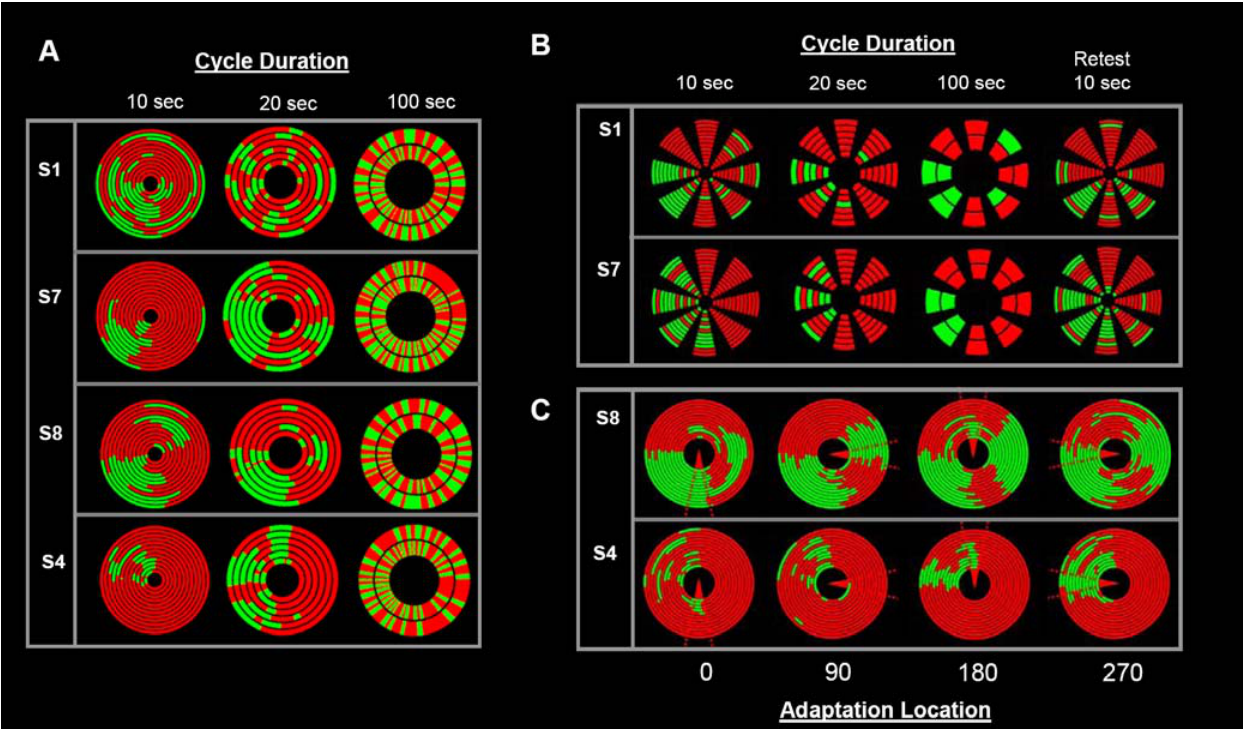
Figure 3. Results from experiment 3, 4 and 5. (A) Data from all 4 subjects tested with 3 different speeds of smooth motion of the target around a peripheral trajectory (the same radial distance used in experiment 2). The left column shows smooth motion at a cycle speed of one loop every 10sec, a rate equivalent to experiment 2a–c. Throughout the 2min trial strong localized biases were reported consistently across all 12 cycle loops. The 2 nd and 3 rd column show a clear decrease in the strength and location specificity of perceptual bias as the target speed slows down to 20 and 100sec per loop. (B) In experiment 4, the 1sec presentation (identical to experiment 2a–c) was used to determine whether the reduction in bias with slower speeds was related to increases in local presentation duration or the elapsed duration between successive presentations at a single location. Data from 2 (of 4) subjects illustrate that localized biases exist independent of the elapsed duration between successive presentations. Local biases are still observed if the inter-stimulus interval is extended to allow cycle rates of 20 and 100sec and at retest 2 weeks later. (C) 2 subjects were tested with 60sec of adaptation to the dominant target (red in both cases) at 4 locations (0 u 90 u 180 u 270 u ) indicated with the red triangle at the center of the corresponding radial plots. After the adaptation period the adapting stimulus was removed and the rivalry targets were presented 45 u preceding the adapting location. The rivalry target then cycled smoothly through the adaptation location for 2 min (12 6 10sec cycles). Together the plots show that adaptation to one of the rivalry targets will result in dominance of the non-adapted target, however, the spatial and temporal extent of this effect is limited and varies across subject and adaptation location.